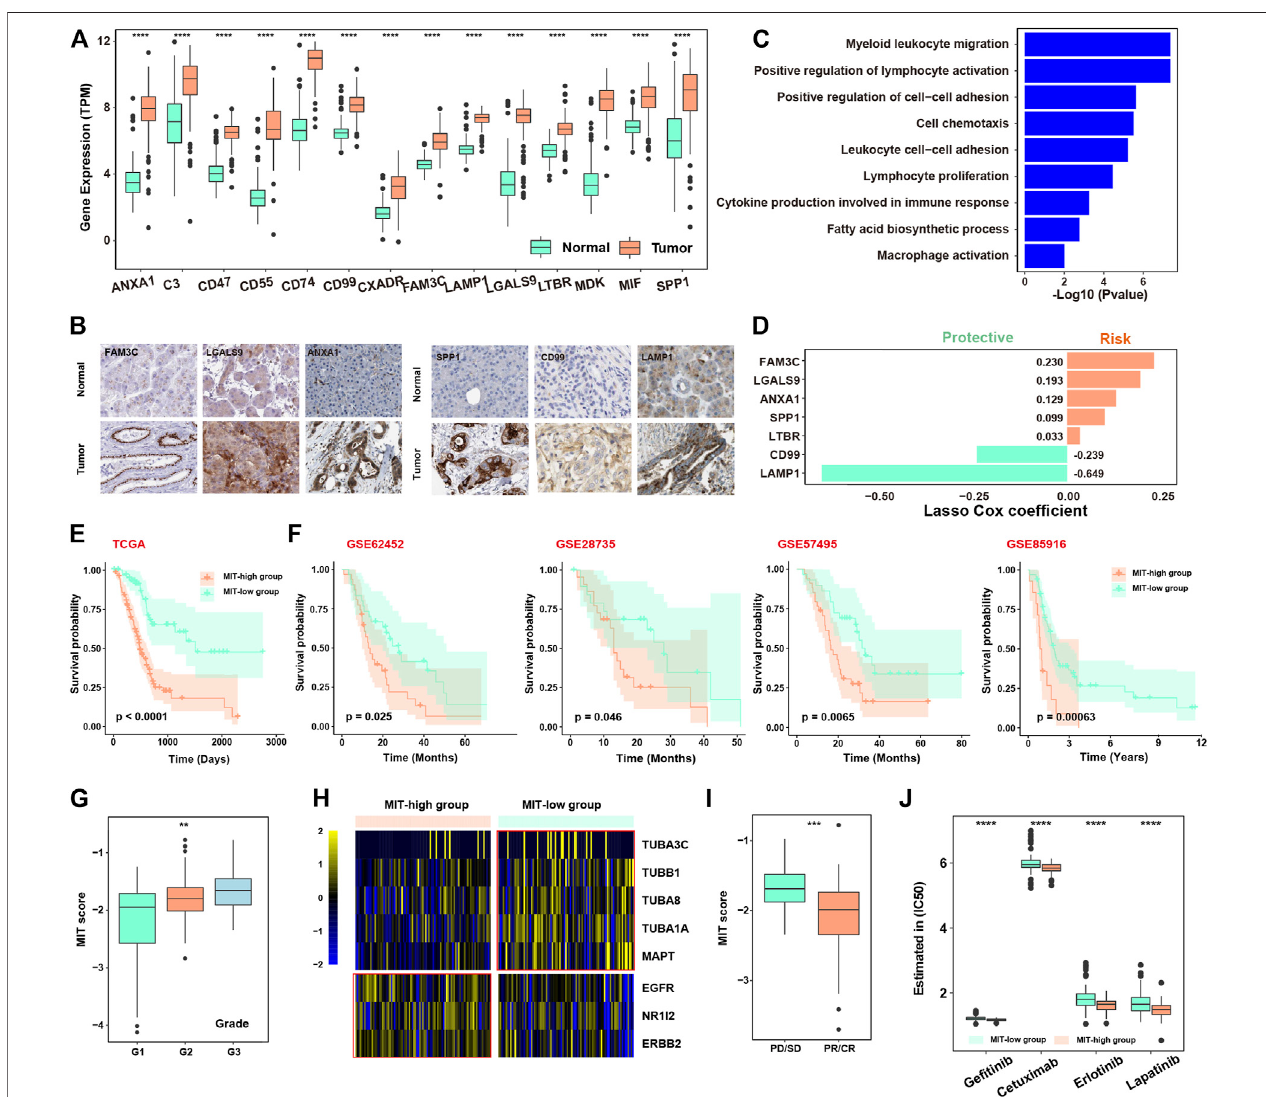
FIGURE 3 | Construction of Malignant-Immune-Talk (MIT) score to measure tumor-promoting immune microenvironment. (A) , boxplot showing the differential expressionofthe14ligandsfromtheabove15ligand-receptorpairsbetweenTCGAtumorandnormalsamples.*, p -value < 0.05;**, p -value < 0.01;***, p -value < 0.001 from two-sided paired Student ’ s t-test. (B) , immunohistochemical (IHC) staining of FAM3C, LGASL9, ANXA1, SPP1, CD99 and LAMP1 in normal tissue (top panel) or PDAC tumor tissue (bottom panel). Scale bar, 50 μ m. (C) , barplot showing the pathways enriched for the 14 ligands from the above 15 ligand-receptor pairs. (D) , barplotshowing the coef fi cients of the 7 genes selected from the lasso cox model. (E) , Kaplan-Meier curveshowing the overall survival differencebetween patients with high MIT socre and patients with low MIT score in the TCGA PAAD cohort. p -value was calculated by the log-rank test. (F) , Kaplan-Meier curve showing the overall survivaldifference betweenpatientswith high MIT socreand patients withlowMIT score in four independent cohorts ofPDAC (GSE62452, GSE28735, GSE57495 and GSE85916). p -value was calculated by the log-rank test. (G) , box plot showing the MIT scores among different clinical grades. (H) , Heat map showing the differential expression of therapy-related genesbetweenhigh and low MIT groups. (I) , box plot showing thedifferent MIT scores between chemotherapy responder group ( p D/SD) and chemotherapy non-responder group ( p R/CR). (J) , box plot showing the difference in estimated of IC50 for four EGFR inhibitors between high and low MIT group.